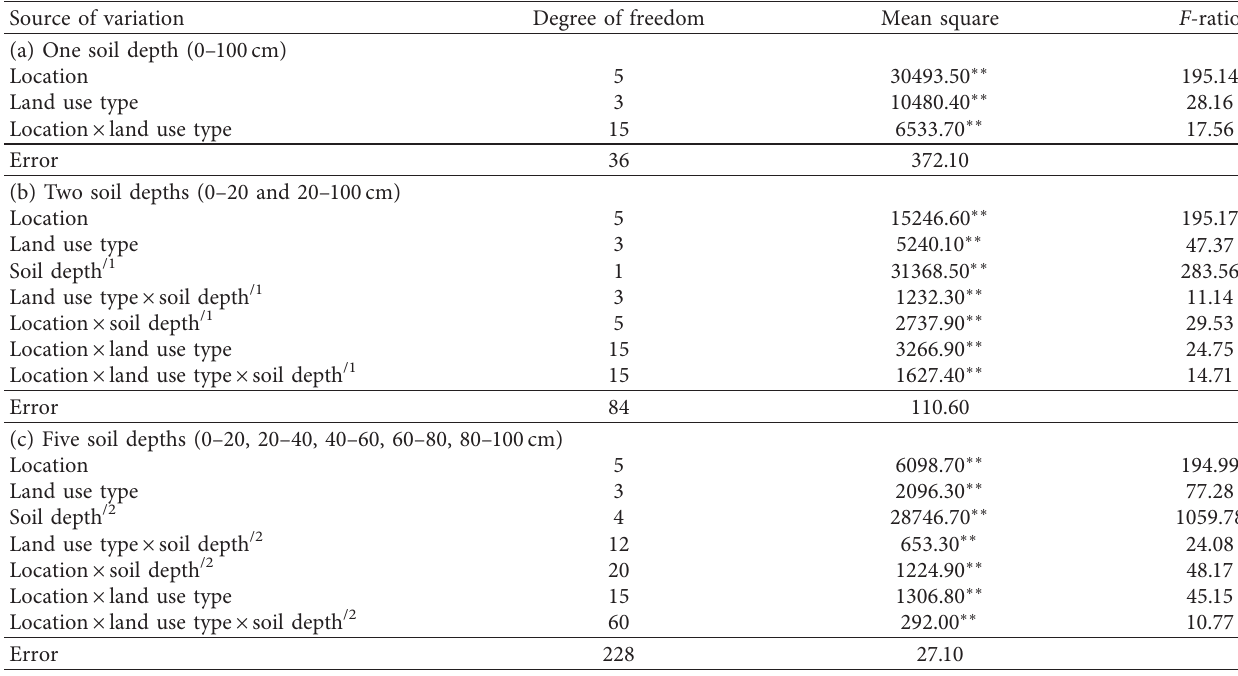
Table 5: Mean squares for soil organic matter in different soil depths from four land use types and six locations.